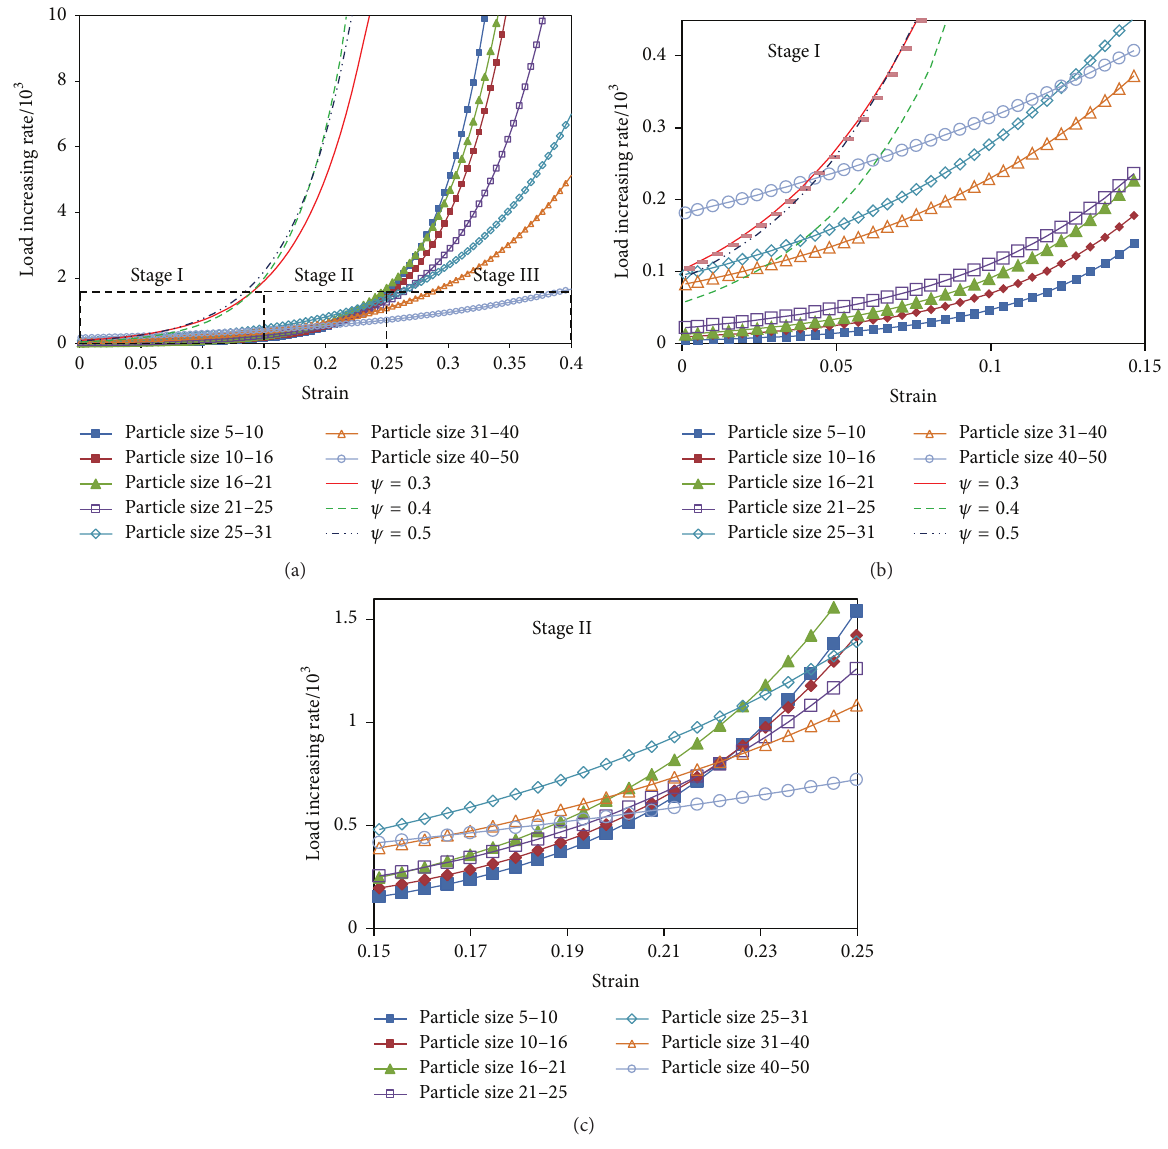
Figure 10: The fitting curve of load increasing